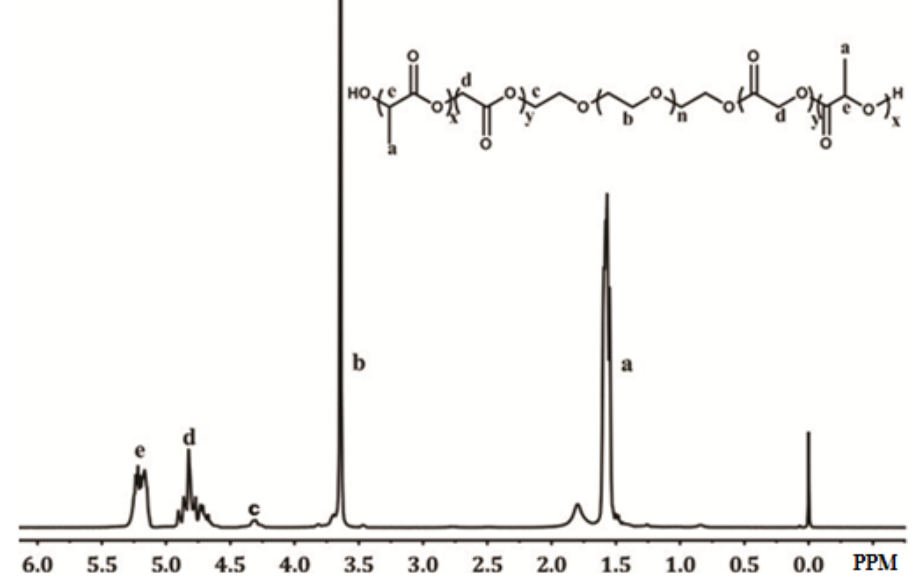
Figure 1. The 1 H NMR spectrum of PLGA-PEG-PLGA copolymer. The proton peaks of a, b, c, d, e indicated δ 1.55 (–OCH(C H δ 4.30 (–OCH CH OCOCH O–), δ 4.82 (–OC H 2 2 2 respectively. The x , y and n represented the repeating number of D , L -lactide, glycoside and PEG unit,